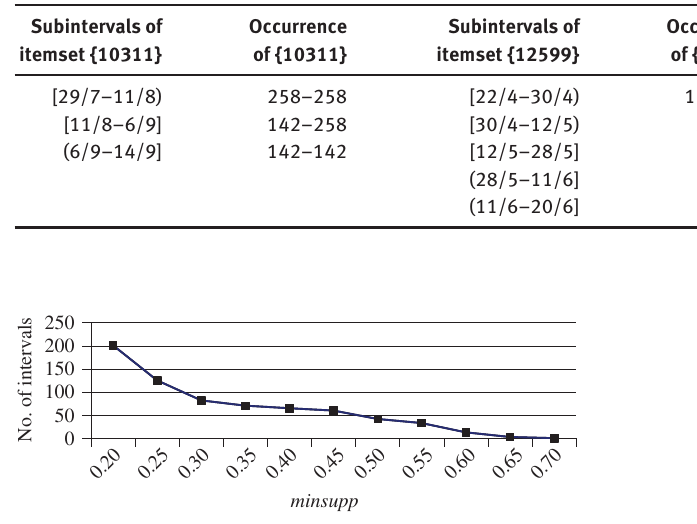
Table 9. Subintervals of Yearly Periodic Itemsets Along with Quantity (for BMS-WebView-1 ).